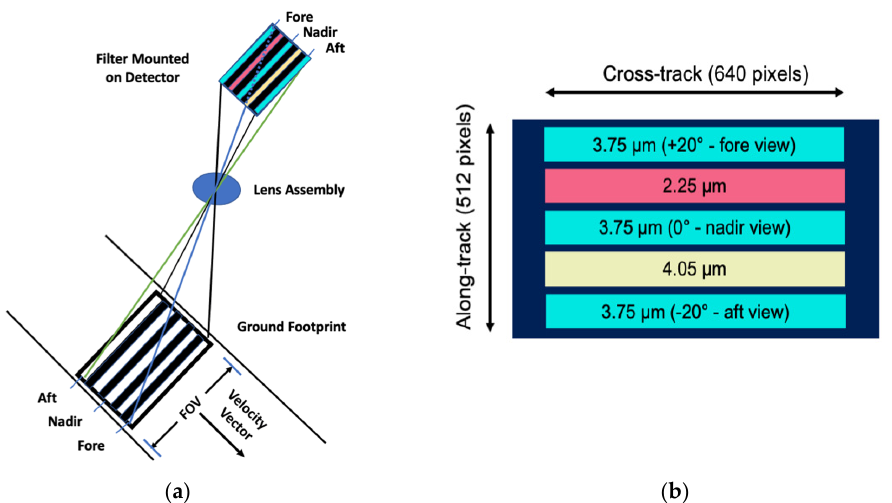
Figure 1. ( a ) Conceptual diagram (adapted from [5]) depicting the ground footprint resulting from a pushframe imager with a single lens assembly and a five-stripe filter mounted on the focal plane array; line colors are used to aid in following individual ray paths; ( b ) Stripe filter configuration to provide fore, nadir, and aft views at 3.75 µ m for stereo imaging with bands at 4.05 and 2.25 µ m for multispectral analysis.